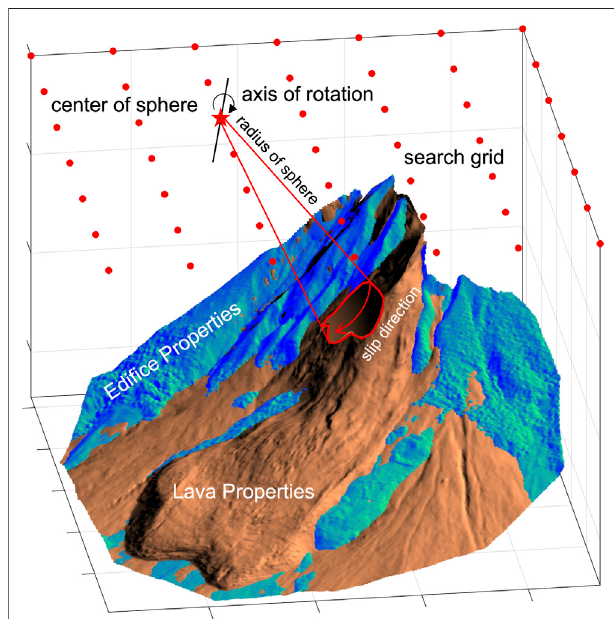
FIGURE 4 | Visualization of Scoops3D analysis. A DEM of Sinabung from 2018 shows a ‘ scoop ’ (red outline) removed from the volcano representing a potential failure volume identi fi ed by Scoops3D. We de fi ne two sets of material properties for the terrain: 1) lava properties are assigned to material that erupted since 2010, shown here in brown shades, and 2) edi fi ce properties are assigned everywhere else, shown here in blue/green shades. In this example, the red dots represent the grid of failure surface rotation centers de fi ned by user input for one elevation. This grid also extends vertically with a user-de fi ned spacing between the layers of grid nodes, but this is not shown in this schematic. The star is the center of the sphere that de fi nesthefailureslipsurfacemarkedinaredoutline,andthestraightlinesare the radius of the sphere. The failure surface is where the sphere intersects the topography.The axisofrotation forthefailure forthis example isshown bythe blackline.Arrowsindicatethedirectionofrotationandslip.Scoops3Diterates across the search grid, varying the radius of the sphere at each point, and calculates the FOS for hundreds of potential failure surfaces. Scoops3D output includes the minimum FOS and associated potential failure volume for each DEMcelland anewDEMwiththe FOS min failurevolume subtractedfrom the input DEM, as shown